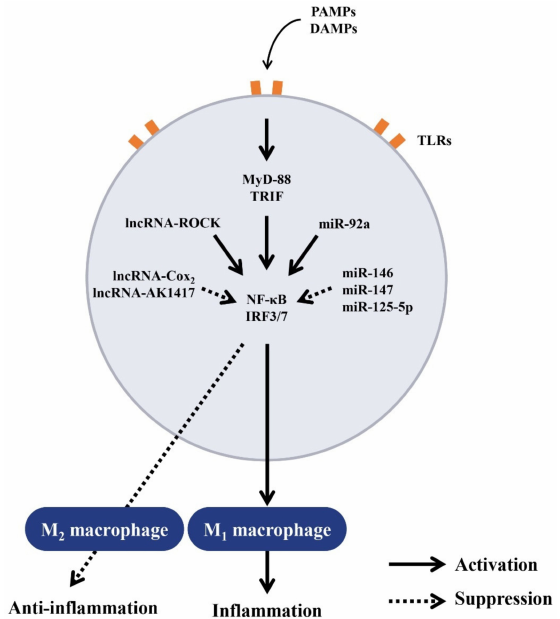
Figure 3. The signaling pathways of Toll-like receptors (TLRs) and their regulations by intracellular ncRNAs in innate immune responses. The molecules released from microbial pathogens (pathogen- associated molecular pattern, PAMPs) or endogenous danger molecules released from damaged cells (damage-associated molecular pattern, DAMP) can bind to TLRs and then activate intracellular adaptor molecules MyD88 or TRIF. A number of ncRNAs may participate in the modulation of NF- κ B and IRF3/7 which enter the nucleus to determine the futures of macrophages differentiation to proinflammatory M1 or anti-inflammatory M2 subpopulation. MyD88: myeloid differentiation factor 88, TRIF: Toll/IL-1 receptor-containing adaptor inducing IFN- β , IRF: interferon regulatory